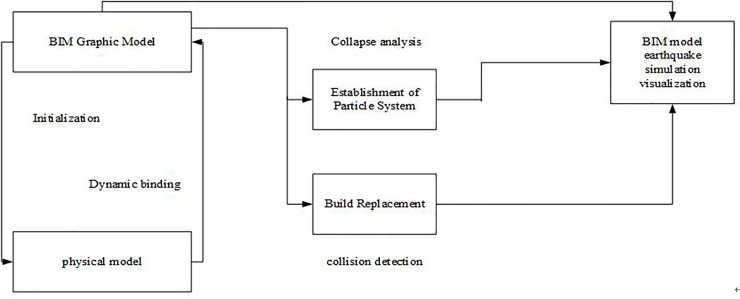
The visualization framework of BIM building model for geological hazard scenario simulation.